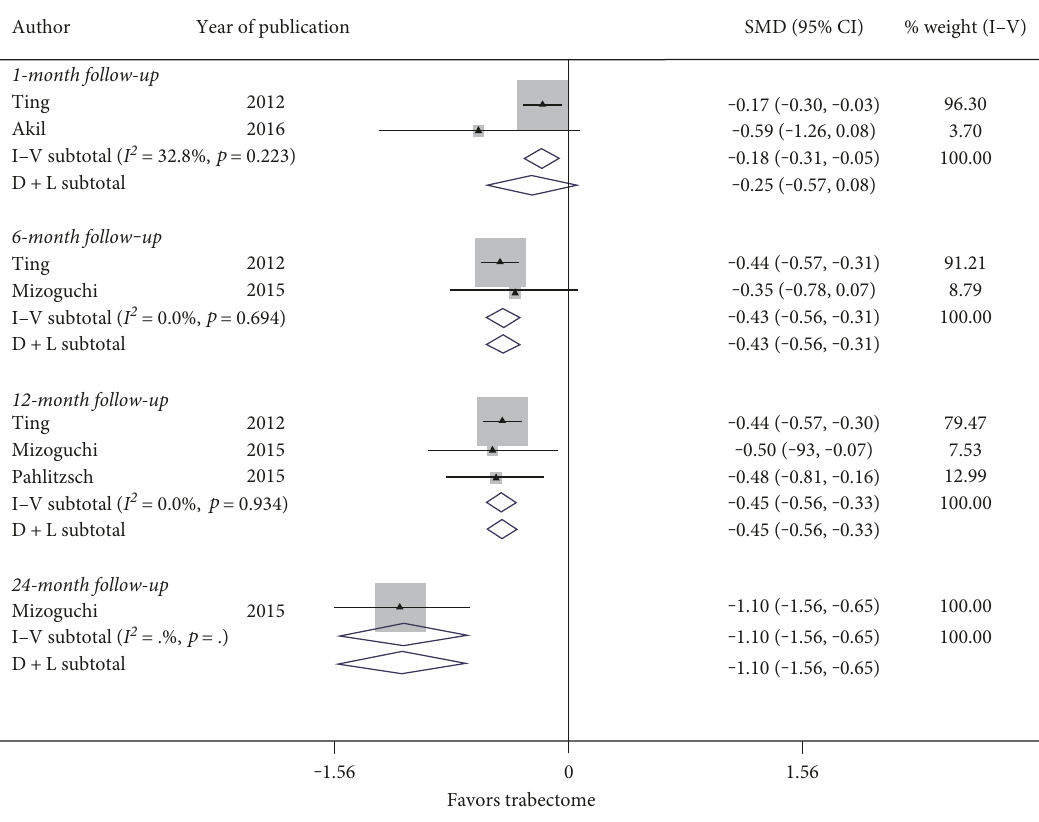
Figure 5: Forest plot for studies examining change in number of glaucoma medications used by follow-up